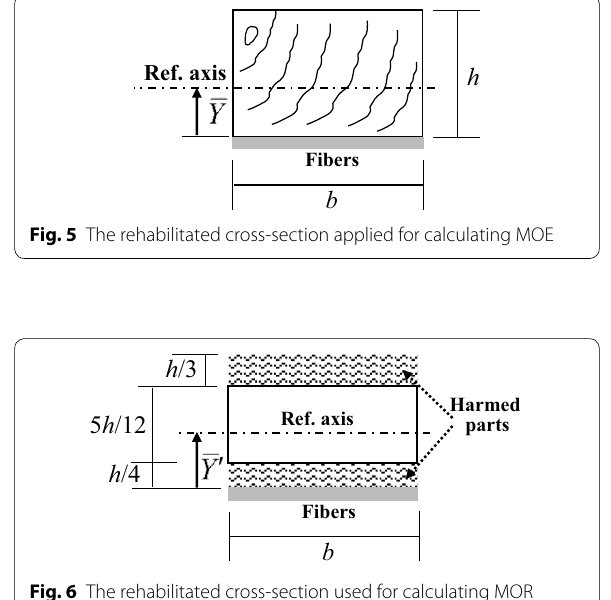
in which P is the overburden load, σ max is the maxi- mum normal stress due to maximum bending moment MOR EI ( M max ), is flexural rigidity, is the modulus MOE of rupture, is the modulus of elasticity, M ө is the moment function, m ө is moment function subjected to unit load, P 1, ∆ the displacement, δ PL is displacement = corresponding to the proportional limit load, P PL is the proportional limit load, P U is the ultimate (maximum) load, b is the width of the cross-section, h is the thickness (the height of the cross-section), and R is the curvature radius.